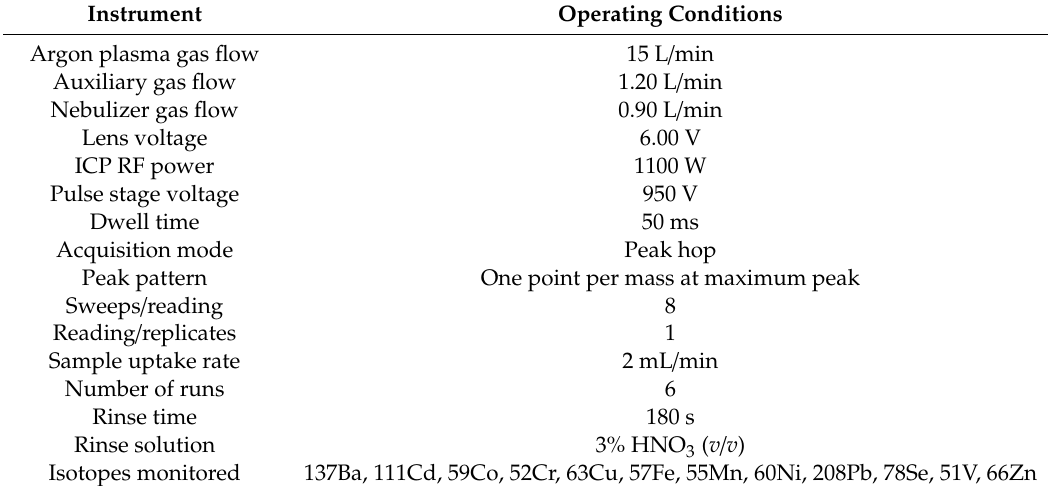
Table 3. Measurement conditions for ICP-MS (Perkin Elmer SCIEX